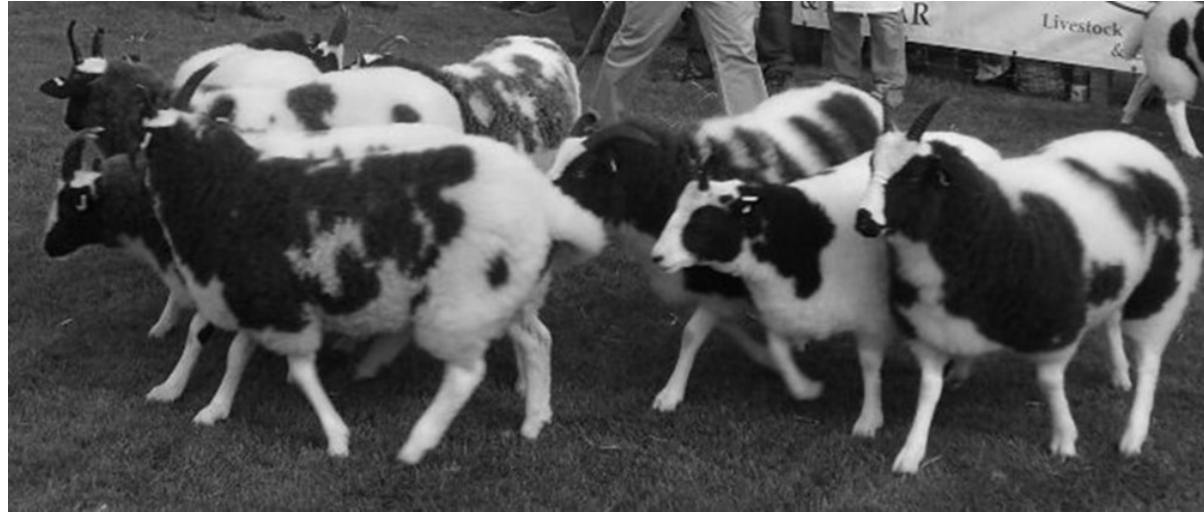
Figure 1 : Example of Jacob ewes showing the variation in extent and distribution pattern of colouration across the body